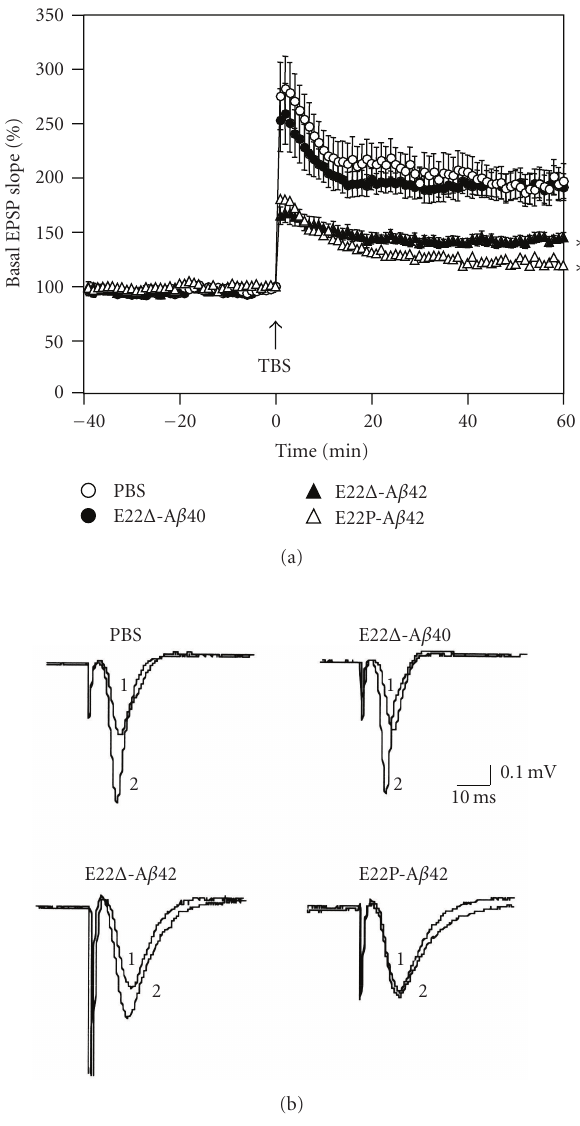
Figure 5: In vivo synaptotoxicity of E22 Δ -A β 40, E22 Δ -A β 42, and E22P-A β 42 estimated by LTP expression. (a) Field excitatory post- synaptic potentials (fEPSPs) were recorded from the CA1 region of rat hippocampal slices (Wistar rats, male, 6 weeks old) by delivering theta burst stimulation (TBS) to the Scha ff er collateral/commissural pathway. LTP was induced by high-frequency stimulation (5 trains consisted of four 100-Hz pulses with an intertrain interval of 200 ms) in the presence and absence of each A β (20 μ g/200 mL PBS), to be injected into the lateral ventricle 20min before stimulation. Each point on the graph represents the mean ± s.e.m. of basal fEPSP slope (0min); n = 12 for PBS, n = 9 for E22 Δ -A β 40, n = 10 for E22 Δ -A β 42, and n = 10 for E22P-A β 40. ∗ P < . 0001 versus PBS; P = . 4258 between PBS and E22 Δ -A β 40. P < . 0001 versus PBS, when fEPSP slopes were compared with 1 to 60 min after TBS. The means between the four groups were compared using analysis of variance followed by Fisher’s protected least significant di ff erence (PLSD) test. ◦ , PBS; • , E22 Δ -A β 40; (cid:2) , E22 Δ -A β 42; (cid:3) , E22P-A β 42. (b) Typical field excitatory postsynaptic potentials at (1) 0 and (2) 60 minutes after